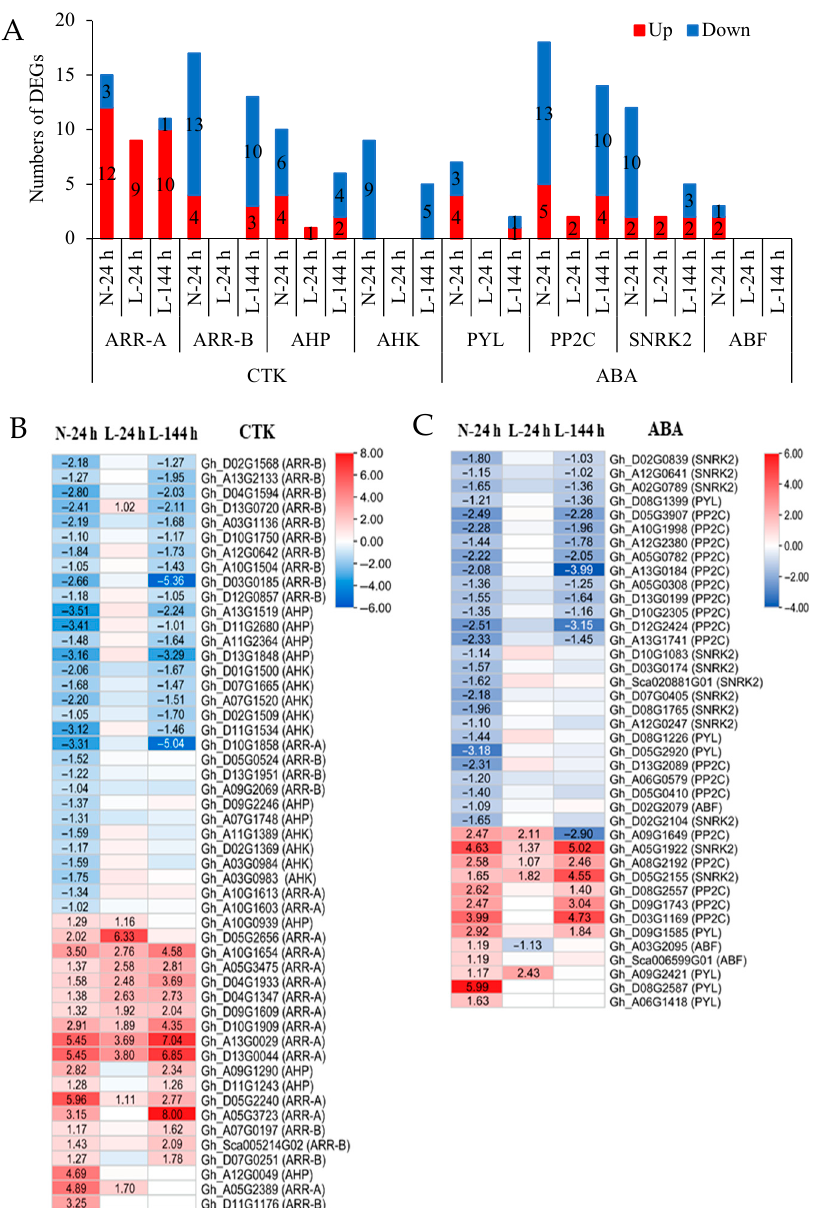
Figure 5. The expressions of CTK- and ABA-signaling genes induced by TDZ at different tempera- tures. ( A ) Numbers of DEGs; ( B ) heatmap of CTK-signaling genes generated based on the RNA-seq data; ( C ) heatmap of ABA-signaling genes generated based on the RNA-seq data. TDZ-induced downregulated and upregulated expressions are indicated by blue and red colors, respectively. The number in the box indicates the fold-change expression of the gene (only those with a ≥ one-fold difference are shown). All the numbers in the heatmap represent fold changes.